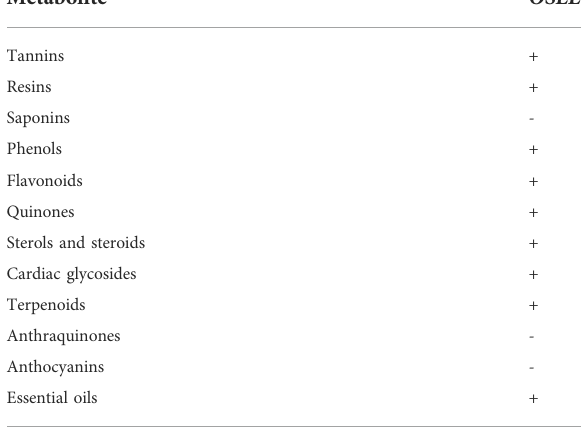
TABLE 2 Phytochemical screening of O. syriacum ethanolic crude